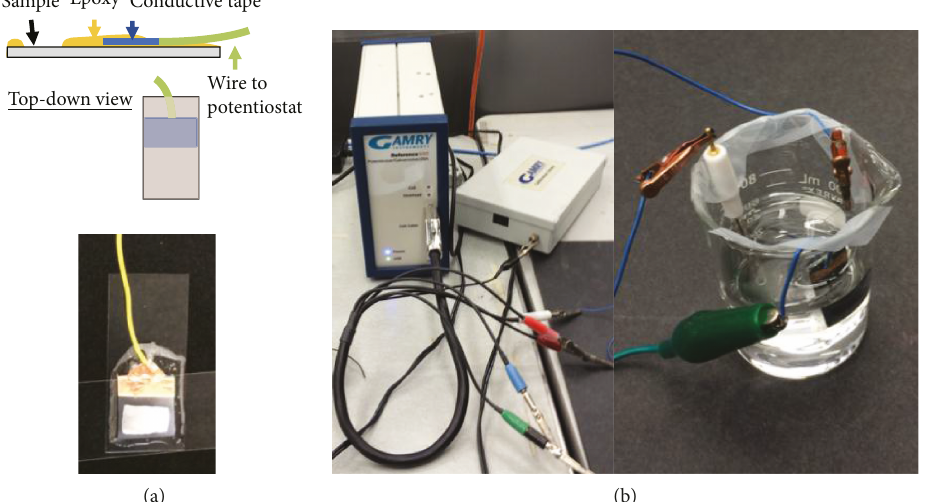
Figure 4: (a) The electrode is prepared for electrochemical testing by passivating the nanowire array onto a glass substrate with epoxy. The active material is isolated with epoxy, and conductive copper tape is used to establish electrical connection. (b) The cell is tested electrochemically using a Gamry Ref. 600 with a 3-electrode setup vs. Ag/AgCl. The counter electrode is platinum.